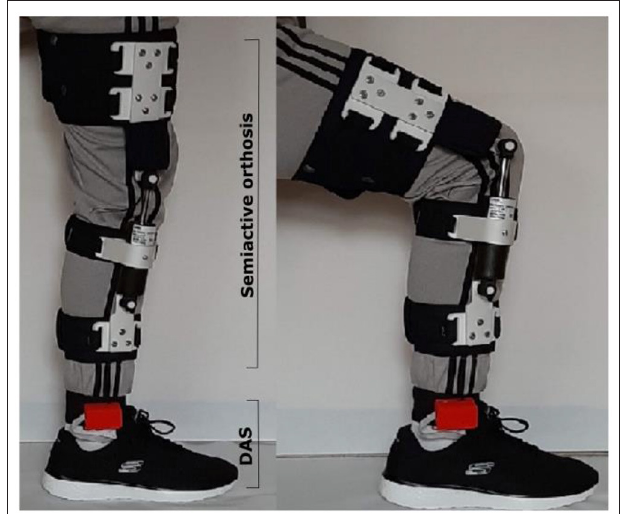
FIGURE 14 | 3D printed orthosis structure placed on the